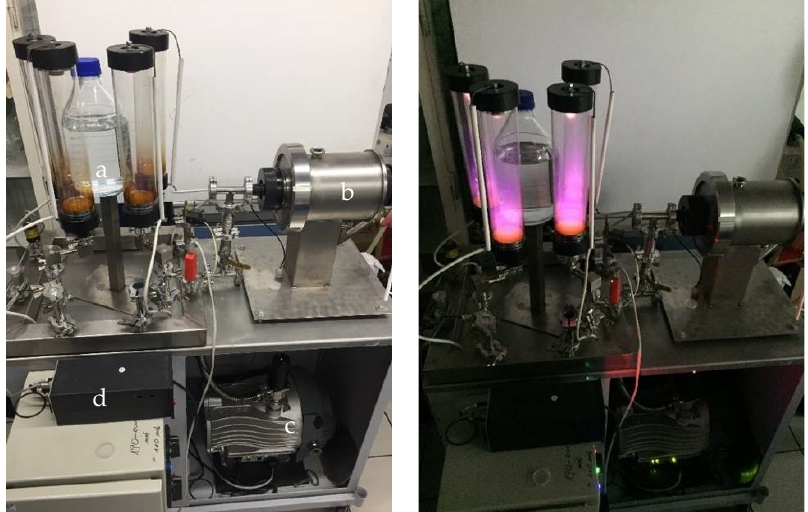
Figure 1. Plasmothrone (without cover) used in this study. ( a ) Lamps, ( b ) pulse generator, ( c ) vacuum pump, and ( d ) power supply [19].